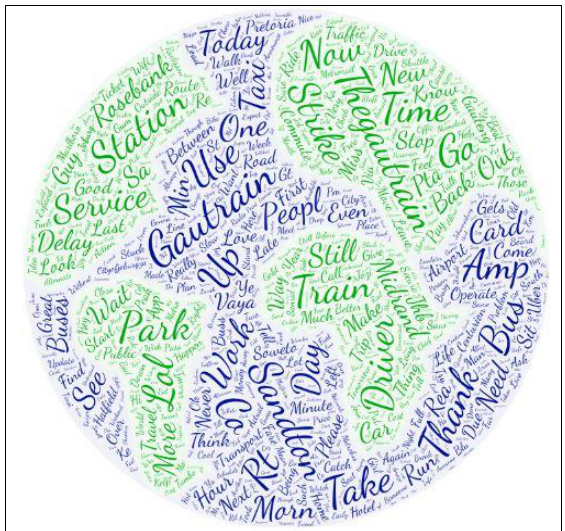
Figure 4. Frequently used words in Tweets during 2018